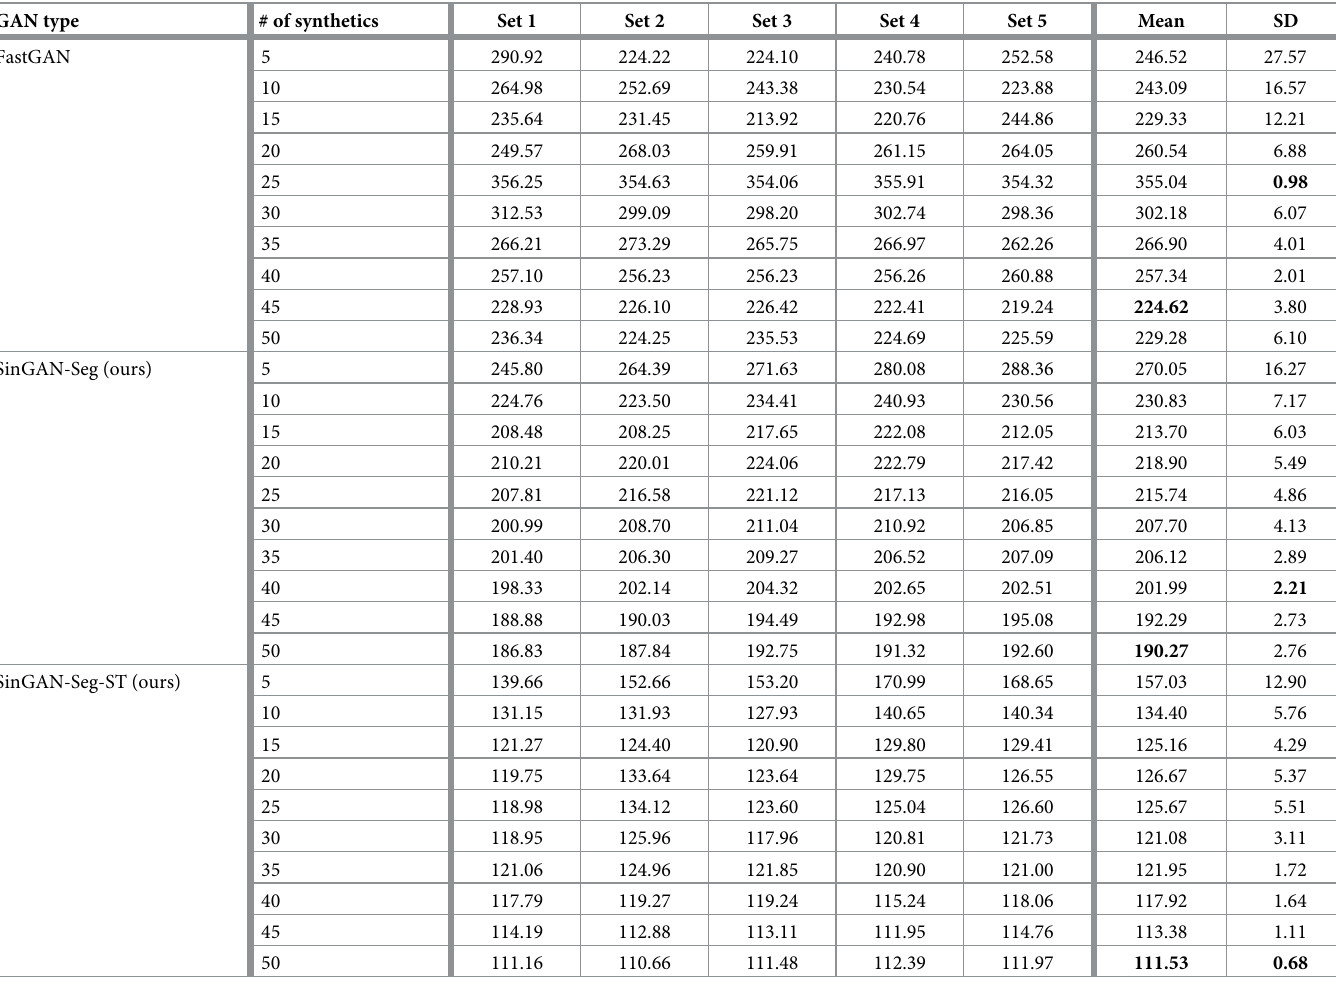
Table 5. FID value calculations between real and synthetic datasets generated from FastGAN, SinGAN-Seg and SinGAN-Seg-ST trained with small datasets. GAN